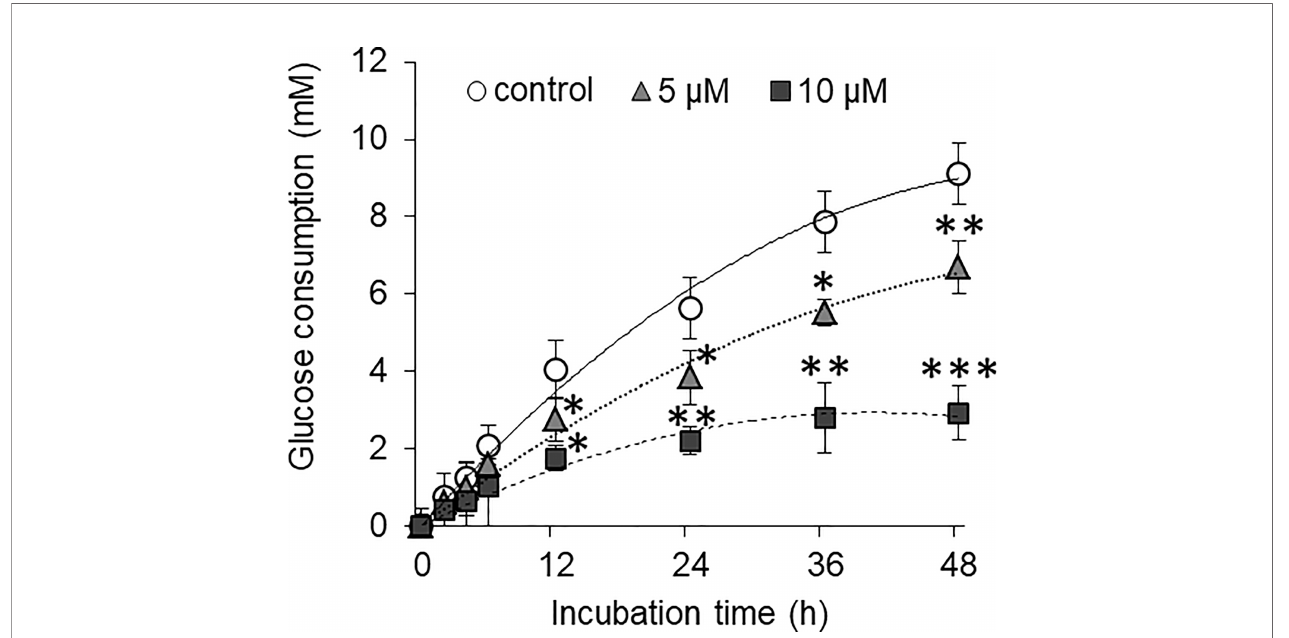
FIGURE 6 | Curcumin inhibits the glucose consumption by HepG2 cells. Cancer cells were treated with curcumin at 5 or 10 µM concentrations for 12 h. Cells were then washed and plated at equal cell density in medium containing standard amount of glucose. Cell-free supernatants were collected at indicated time interval, and the amount of remaining glucose present was estimated. Difference between amount of glucose in culture supernatant and uninoculated medium was calculated to get amount of glucose consumed. The values shown are Mean ± SD of three independent experiments conducted in triplicate. * p < 0.05, ** p < 0.01, *** p < 0.001 vs values of cells of control group not treated with curcumin.